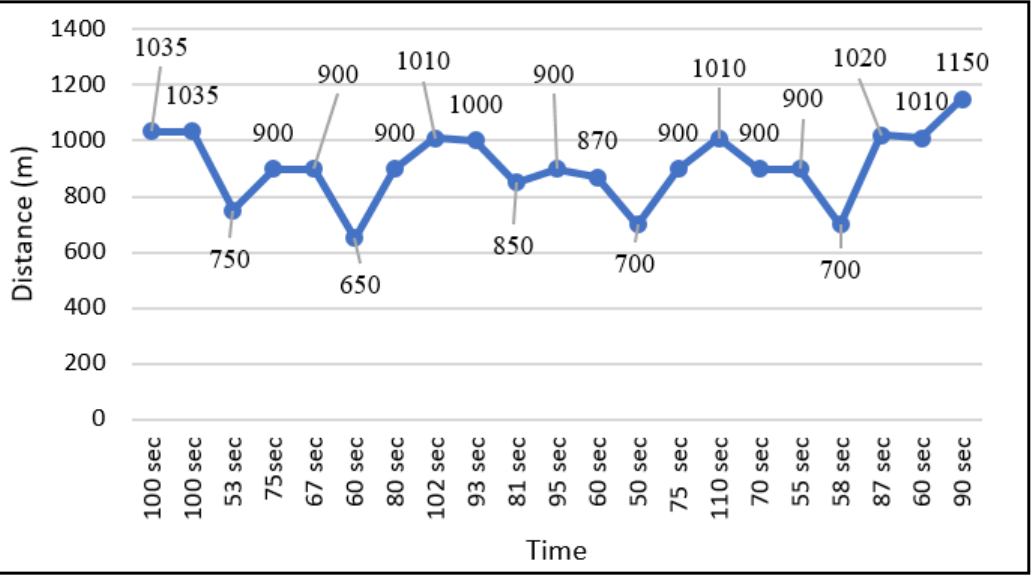
Figure 7. Analysis of Travel Distance of Multan with Respect to Time.